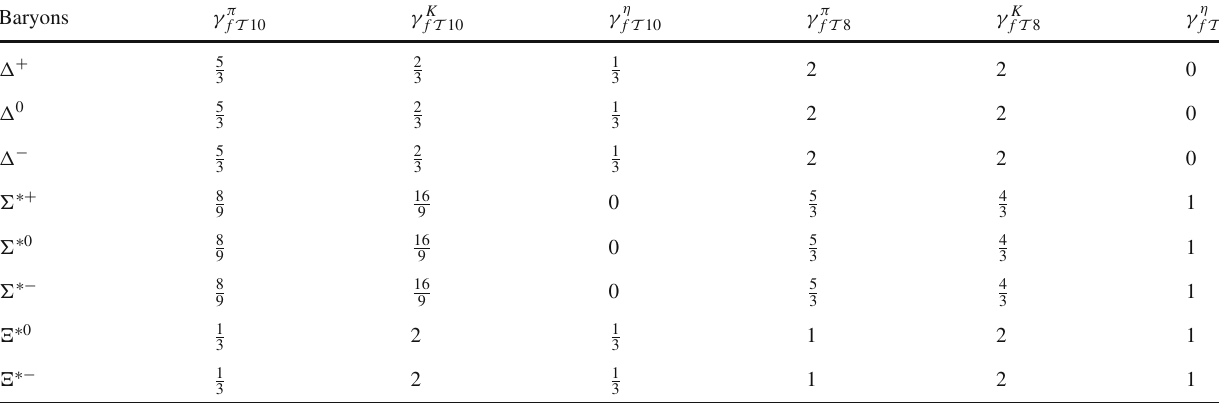
Table 11 The coefficients of the loop corrections to the decuplet to octet baryon transition magnetic moments from Figs. 2(m) and 2(n)